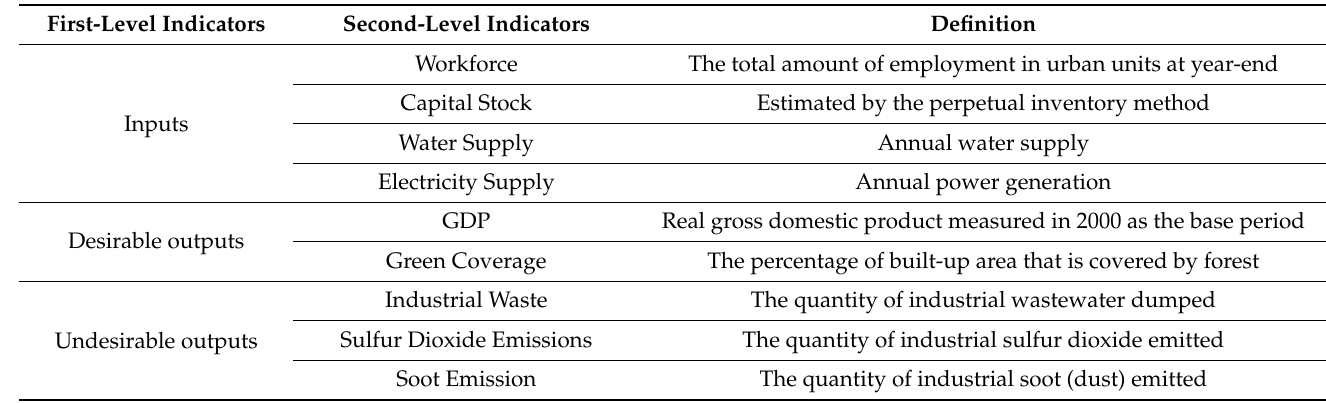
Table 1. Definition of input and output metrics for GTFP